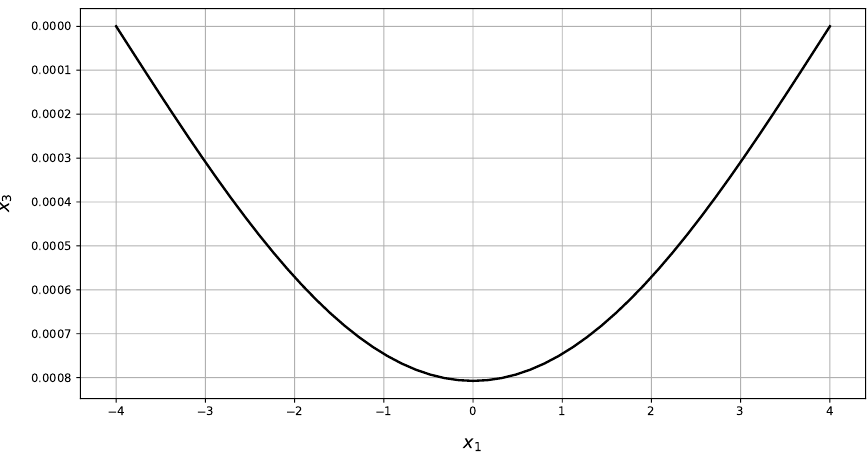
Figure 16. The deflection in section x 2 = 0 of a simply supported rectangular plate.